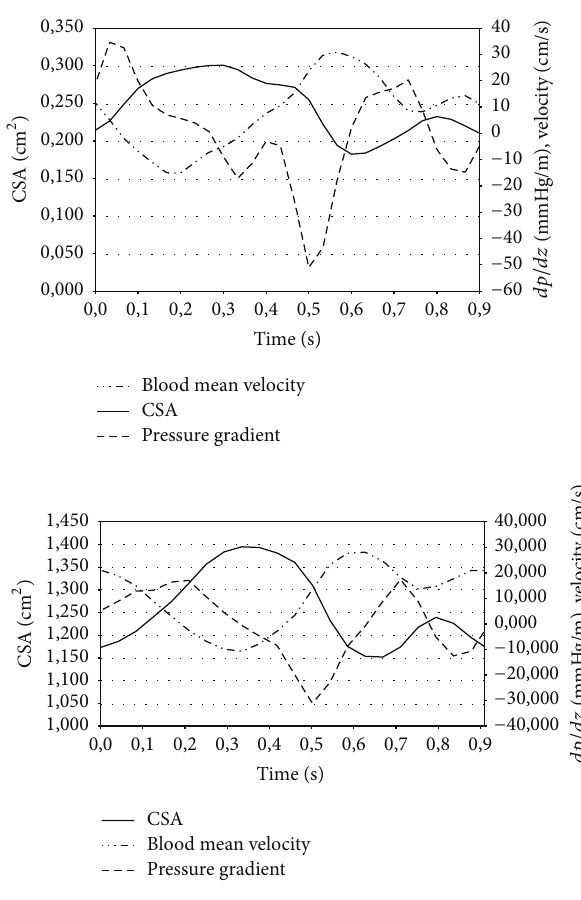
Figure 4: The pressure gradient ( 𝑑𝑝/𝑑𝑧 ) calculated using the “tube- law” is plotted together with the internal jugular vein blood mean velocity ( 𝑤 ) calculated using Womersley equations and the cross- sectional area (CSA). A single cardiac cycle is